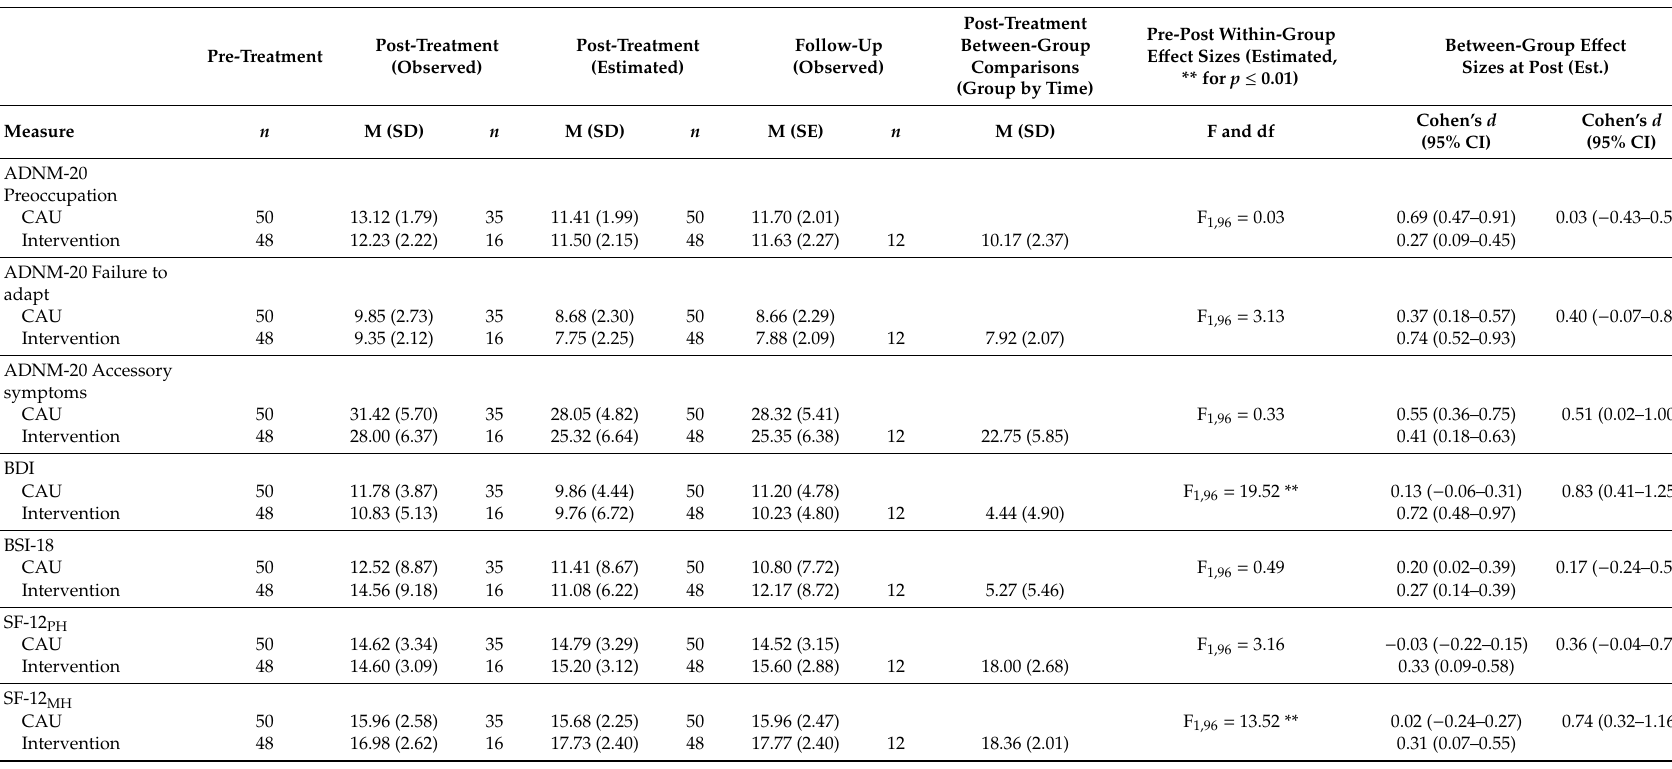
Between-Group E ff ect Sizes at Post